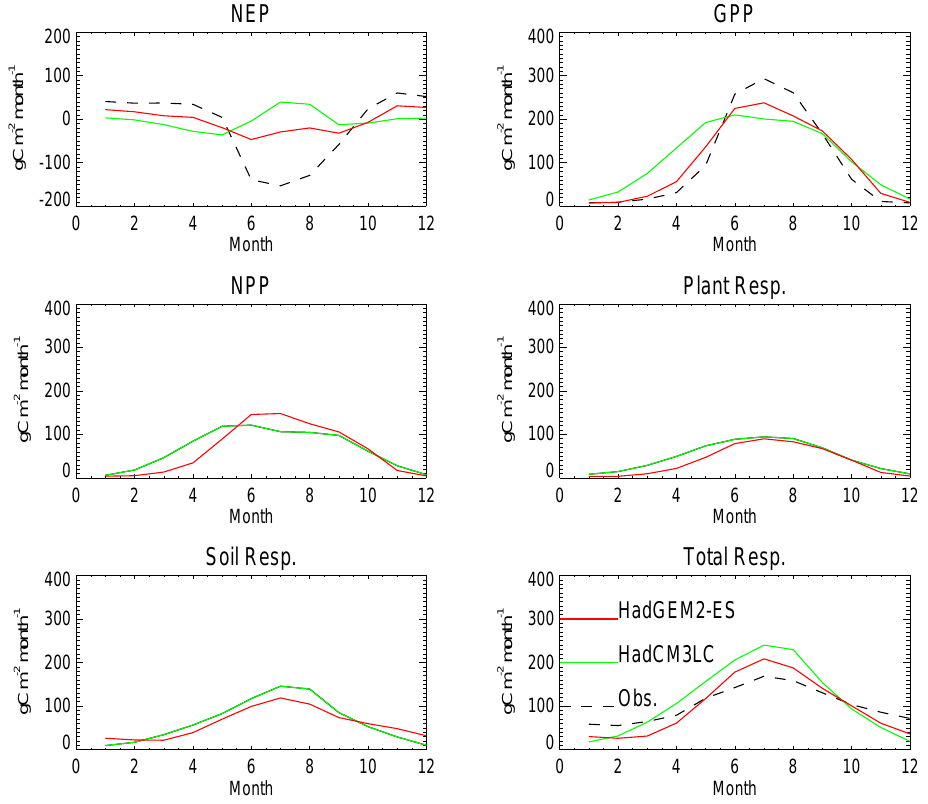
Fig. 19. Observed and simulated carbon fluxes at Harvard Forest site, USA. HadGEM2-ES (red), HadCM3LC (green). Observations are the mean of 8yr from AMERIFLUX,